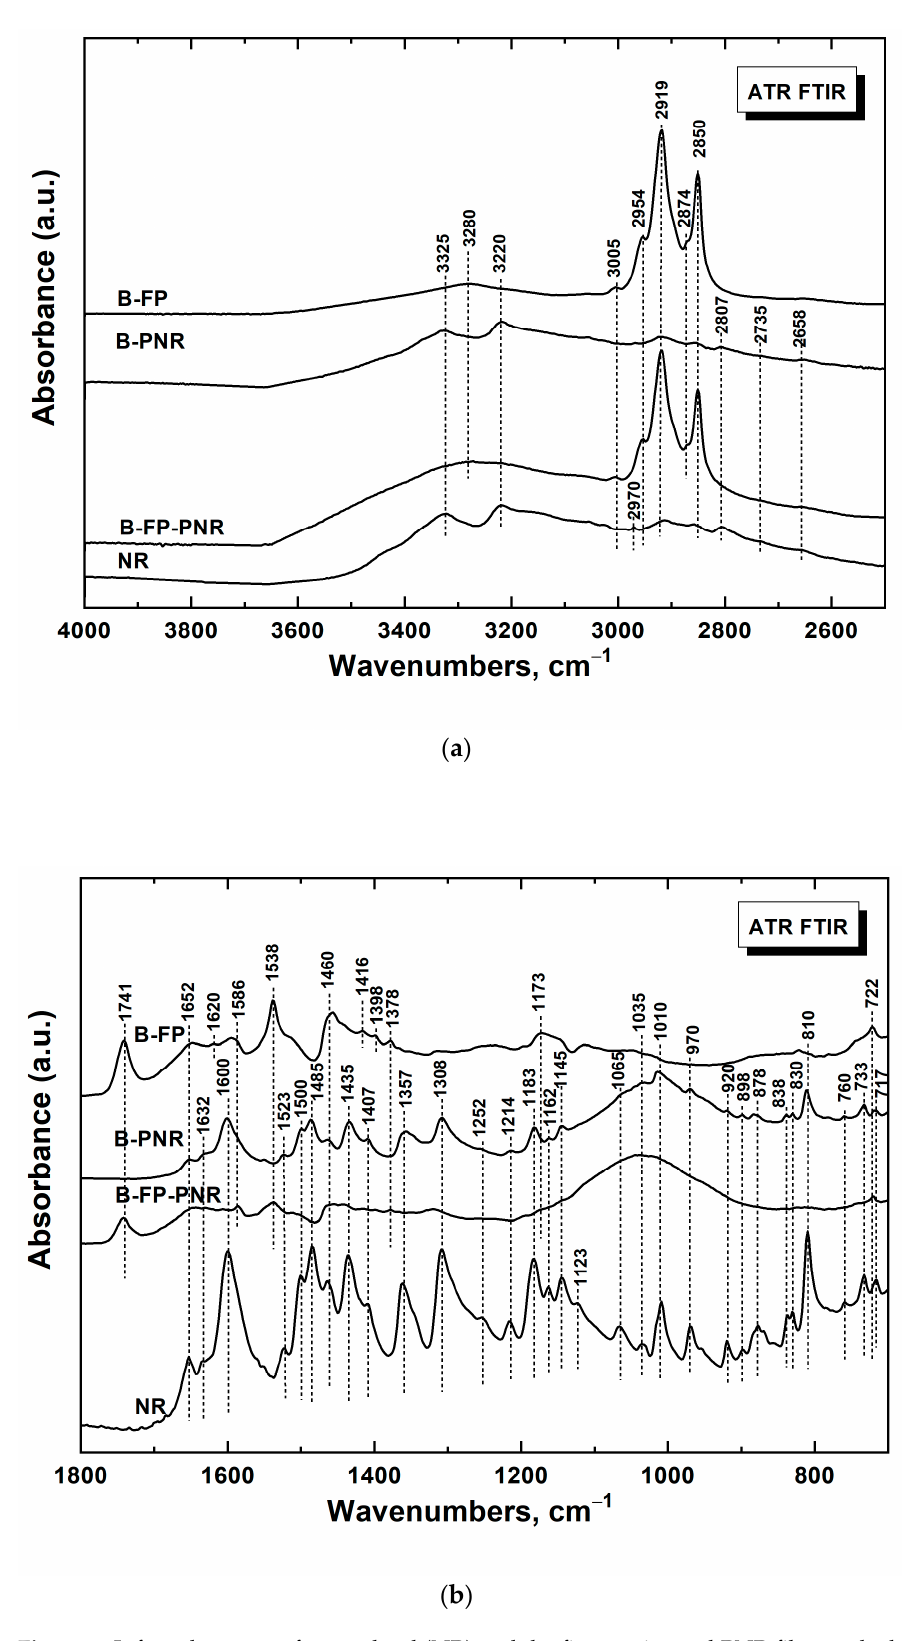
Figure 6. Infrared spectra of neutral red (NR) and the fingerprint and PNR film on the brass plate (B) in the wavelength range from ( a ) 2500 to 4000 cm − 1 and ( b ) 1800 to 700 cm − 1 . B-FP, brass-fingerprint; B-PNR, brass-PNR film; B-FP-PNR, brass-fingerprint-PNR film.